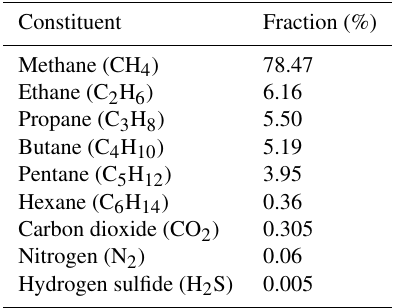
Table 3. Molar composition of natural gas in Niger Delta (Nige- ria) based on the measurements of Sonibare and Akeredolu (2004), averaged over 10 flow station. The hydrocarbons are merged ac- cording to the number of C